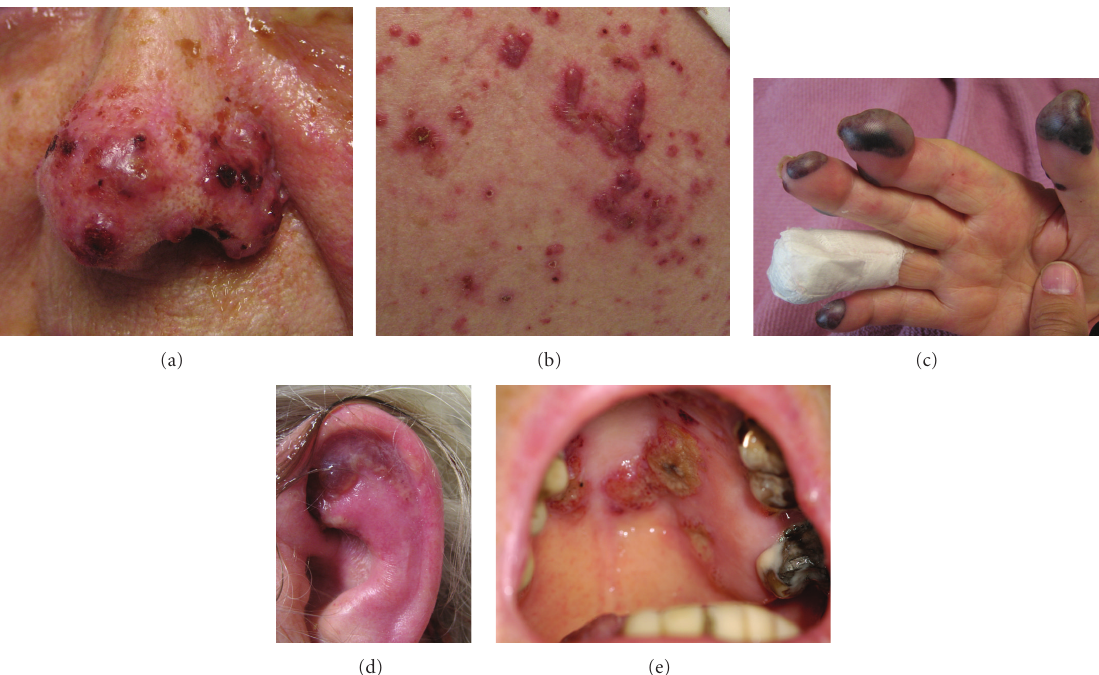
Figure 1: (a) Drug-induced Sweet Syndrome demonstrating tense vesicles and bullae with surrounding erythema over nose. (b) Tense inflammatory vesicles and bullae over central back. (c) Hemorrhagic bullae of distal finger pads and lateral fingers. (d) Erythema, edema, and focal bullous change overlying the cartilaginous portions of both ears. The non-cartilagenous lobes demonstrated no inflammatory changes. (e) Bullous lesions and erosions on the hard palate.